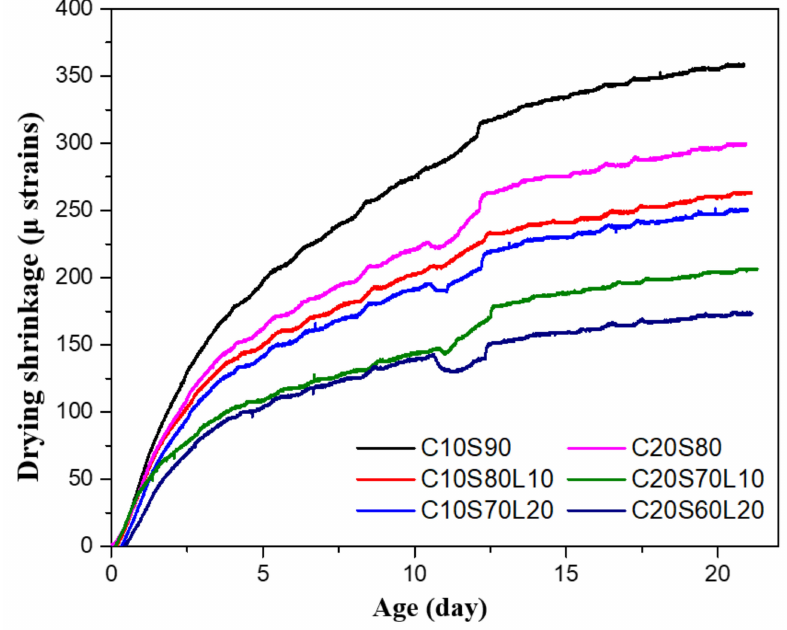
Figure 9. Drying shrinkage of alkali-activated slag mortar with di ff erent